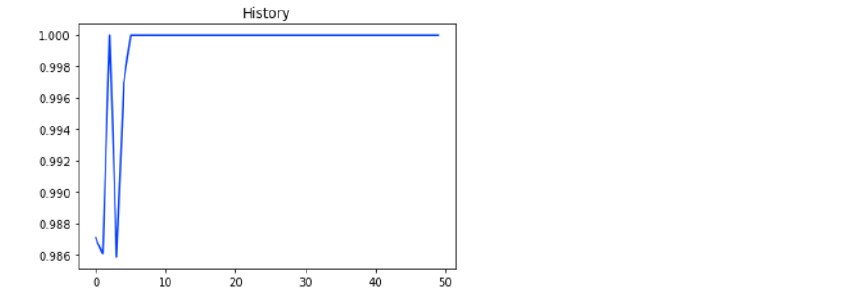
Figure 2. Training history of proposed ensemble model with self-consistency test.